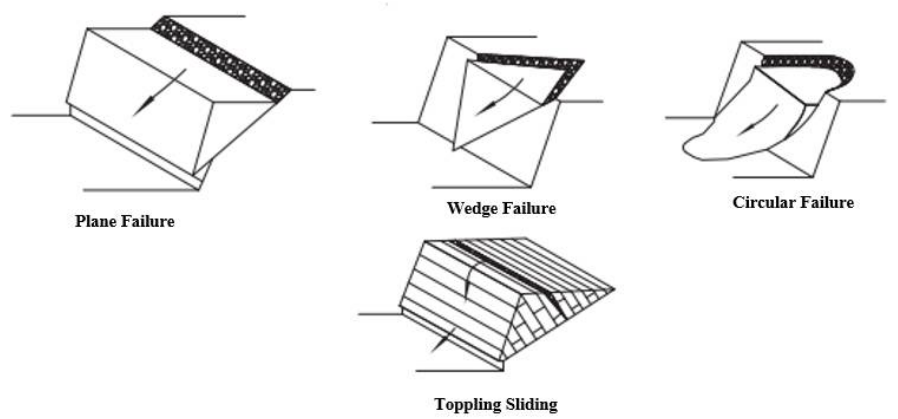
Figure 4. Classes of failure in rock slope (Adapted from [44]).